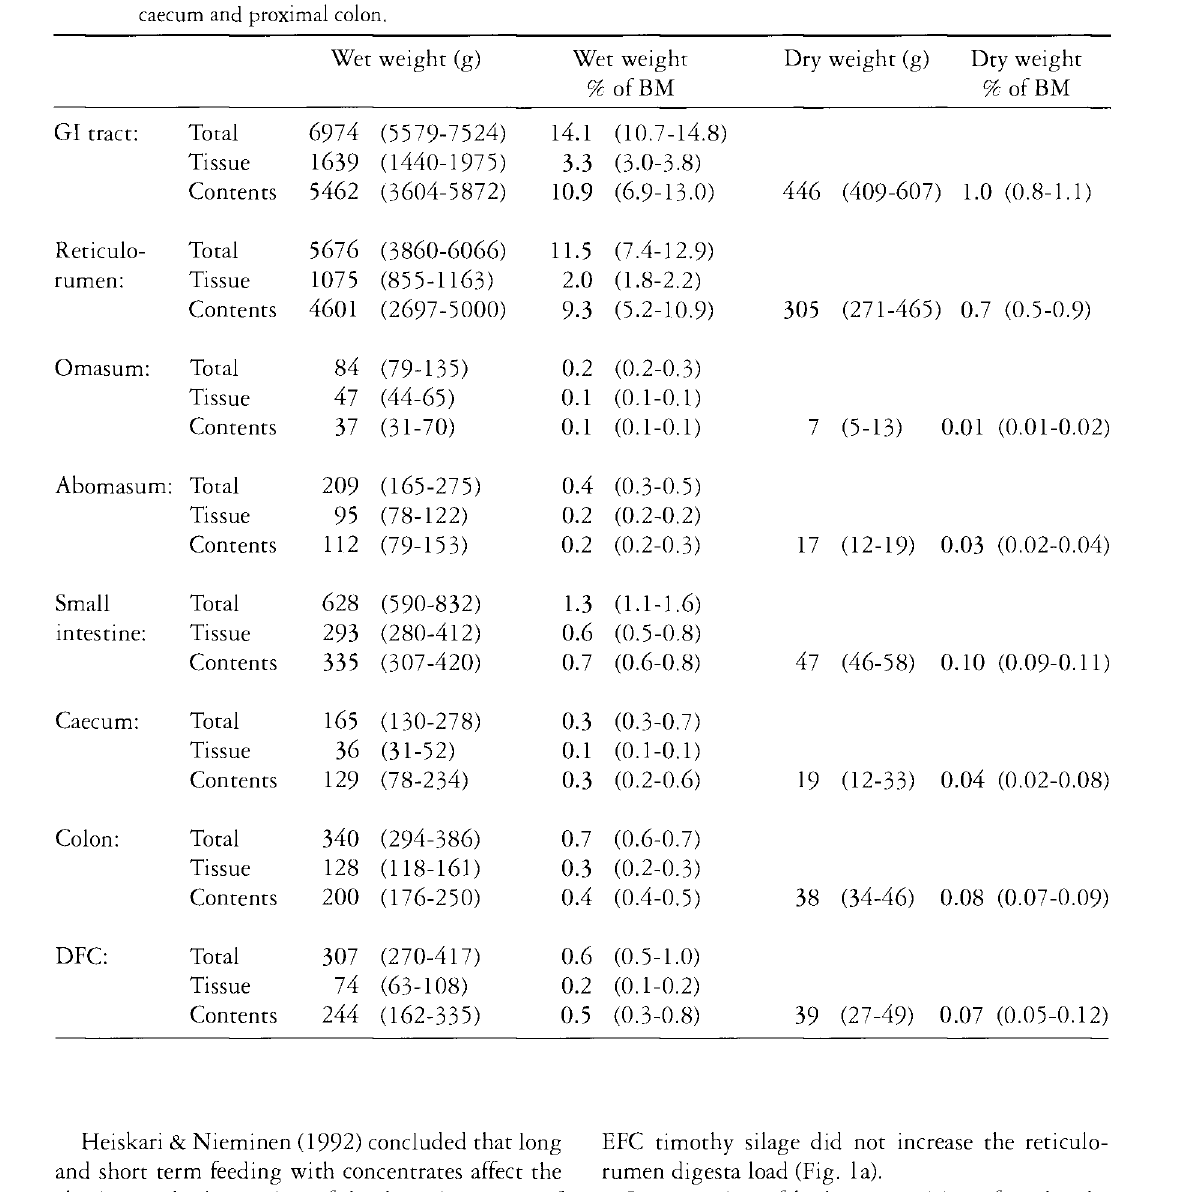
Table 3- Total, tissue and contents wet weight , wet weight % of body mass (BM), dry weight and dry weight % of BM of the gastrointestinal (GI) tract in male reindeer calves fed early harvested first cut timothy silage (Pbleum pratense) (median and range; « = 5). Distal fermentation chamber (DFC) represents the summarised values of caecum and proximal